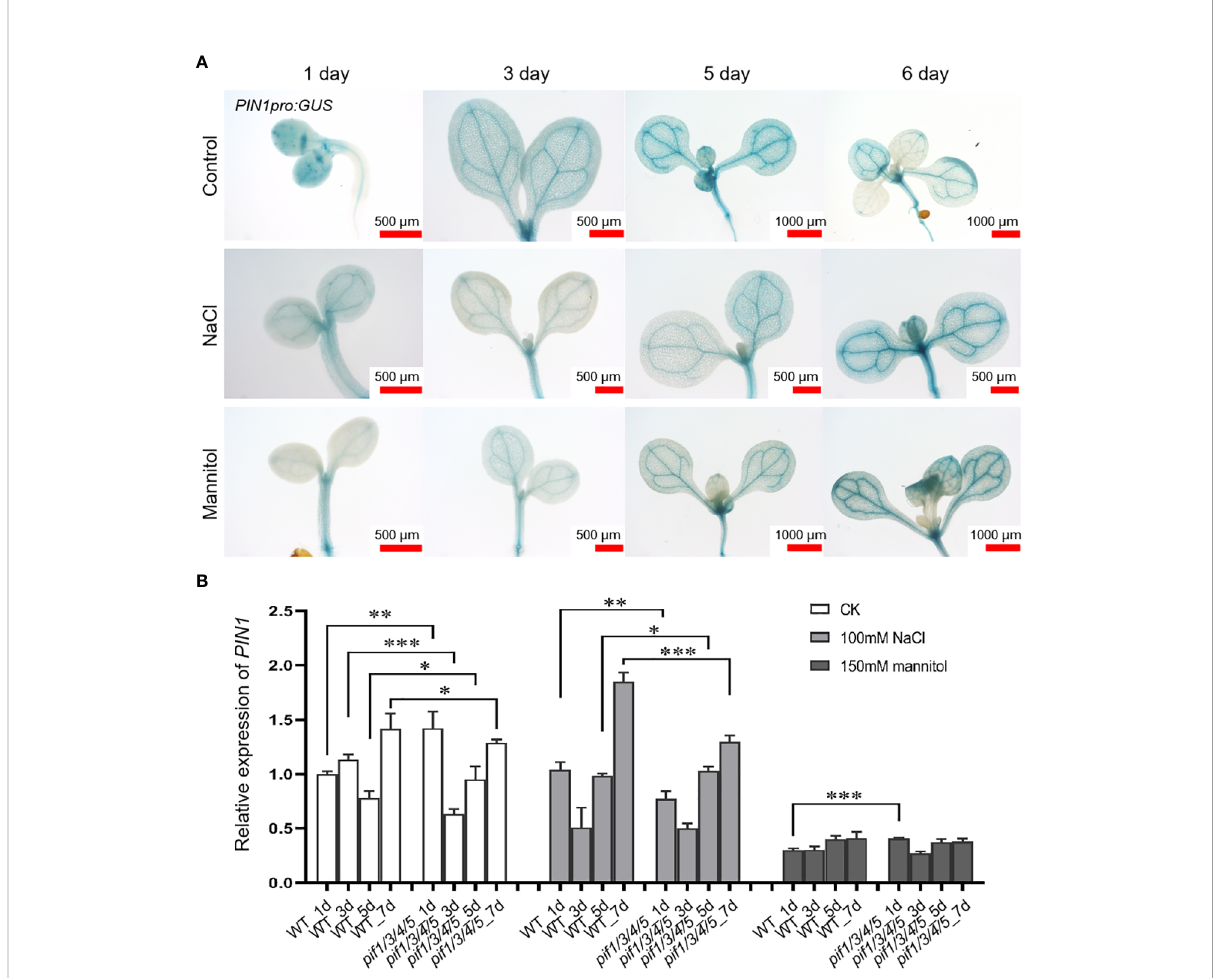
FIGURE 2 Analysis of the expression of PIN1pro: GUS and PIN1 gene after being treated with NaCl and mannitol. (A) Analysis of the expression of PIN1pro: GUS in whole cotyledons (up panel) during the development of seedlings grown under control, NaCl, and mannitol conditions, respectively. The seedlings of PIN1pro:GUS were grown in 1/2 MS plates plus 100 mM NaCl or 150 mM mannitol for 1, 3, 5, and 6 days, respectively; the seedlings of PIN1pro:GUS grown in normal 1/2 MS plates were used as controls. Then the seedlings were harvested and used for detecting the GUS activities by GUS staining, as described in Materials and Methods. (B) qPCR analysis of the relative expression of PIN1 under control, NaCl, and mannitol conditions, respectively. Relative expression indicates the mean value ( ± SD) of three independent experiments. The black stars represent student ’ s t-test of pif1/3/4/5 vs WT. *p < 0.05; **p < 0.01; ***p <